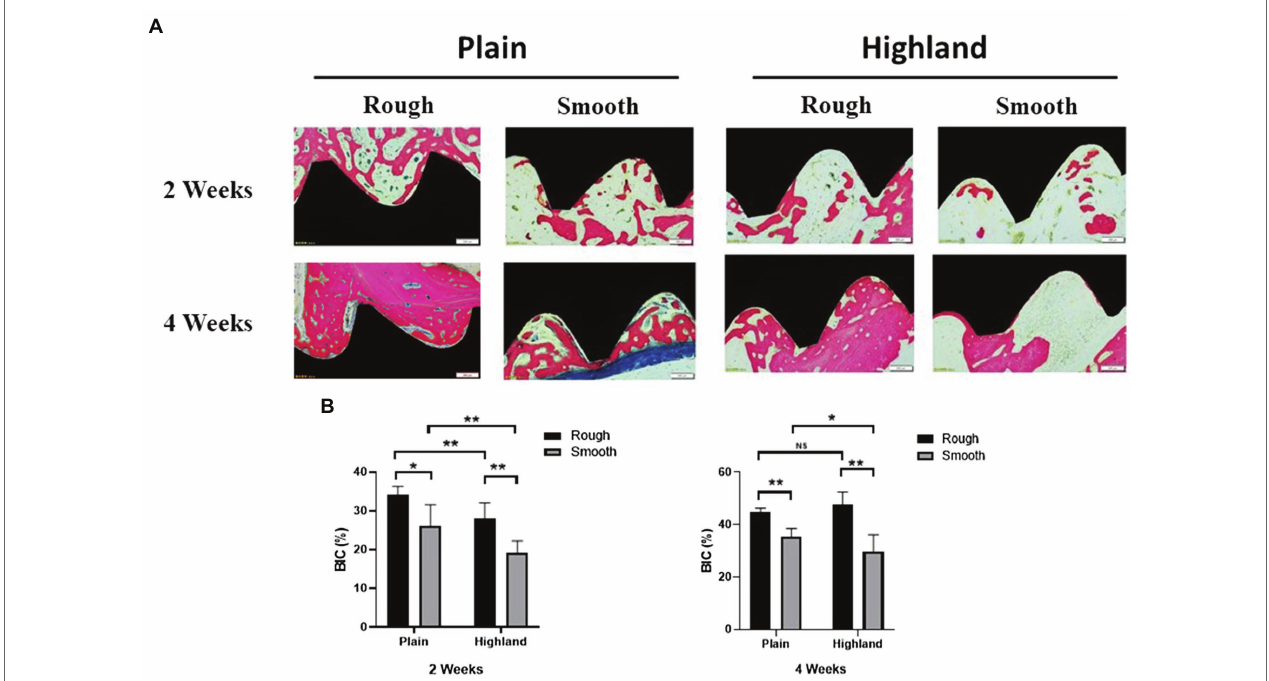
FIGURE 6 | Histological observation of implants and the surrounding tissues [methylene blue-acid fuchsin (A) ]; comparison of Bone-to-Implant Contact (BIC; %) at week 2 and 4 (B) . NS, no significance; * p < 0.05, ** p <